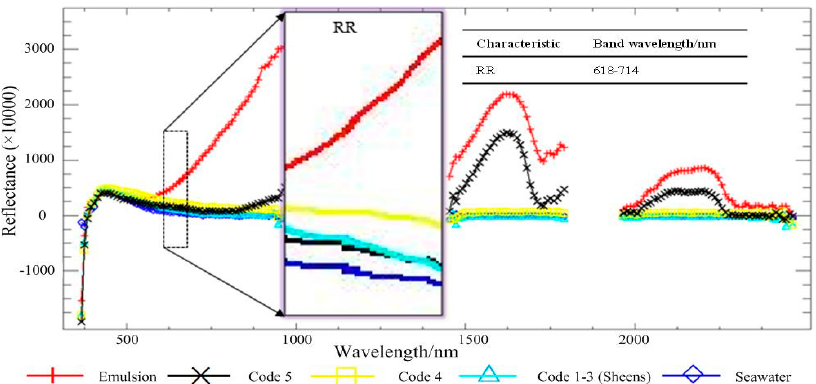
Figure 13. Spectral curve analysis identifying different thickness of oil slicks by RR. Red, black, yellow, cyan, and blue lines represent emulsions, oil slicks of code 5, oil slicks of code 4, oil slicks of code 1–3, and seawater, respectively.